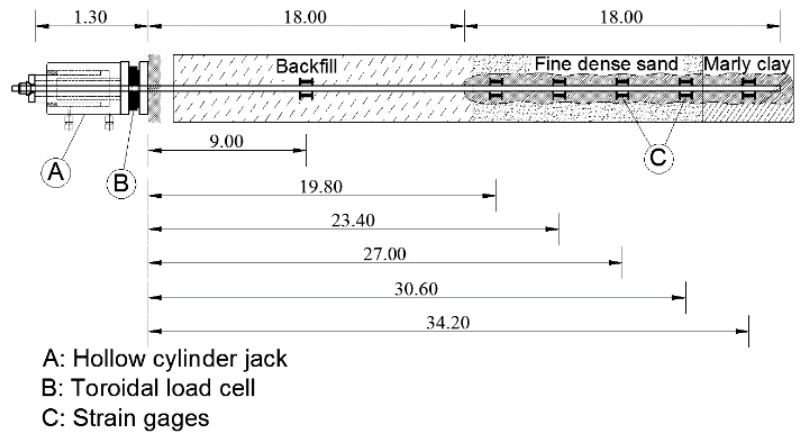
Figure 3. Setup of the instrumented anchor subjected to loading test.